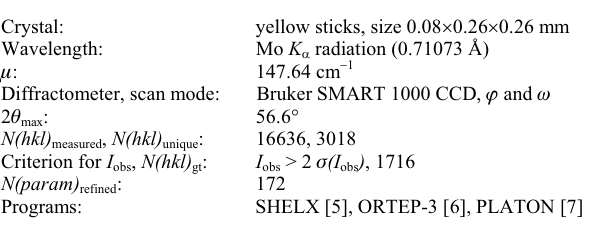
Table 1. Data collection and handling.